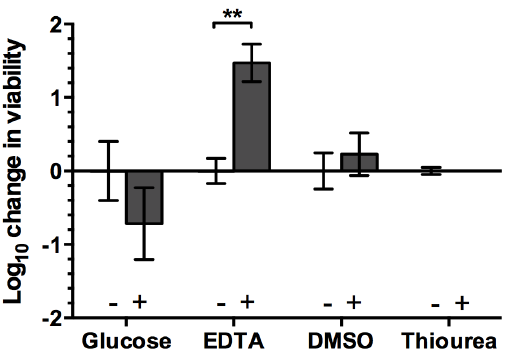
Fig. 6. Comparison of log 10 change in E. coli viability following exposure to CB-L with and without the addition of glucose (40 mM), EDTA (10 mM), DMSO (1%), and thiourea (150 mM). **, p ,